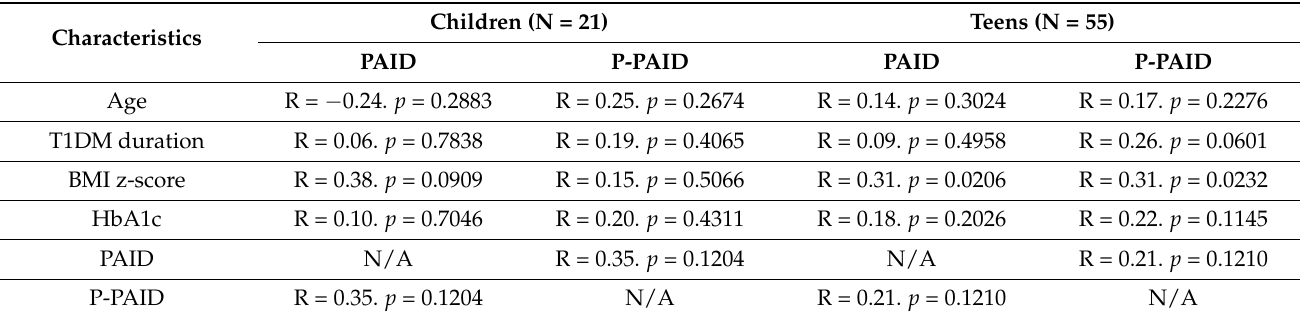
Table A1. Correlation of PAID scores at baseline (1st PAID, i.e., before pandemic) with clinical characteristics (continuous variables). Correlations are expressed as R (Spearman rank correlation).